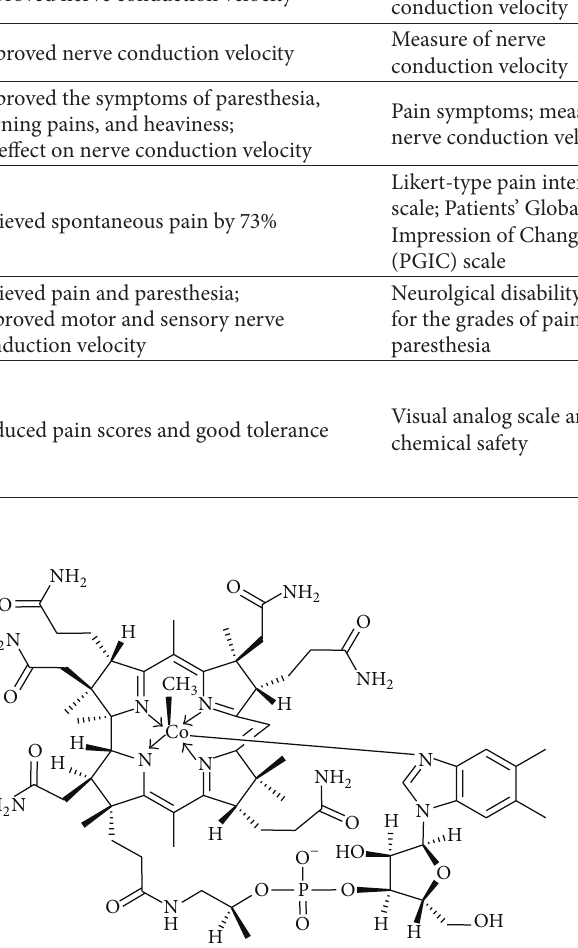
Figure 1: The chemical structure of